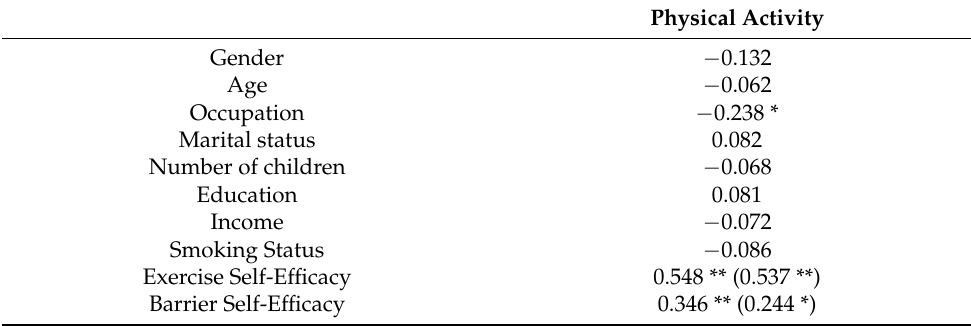
Table 2. Correlations of physical activity, demographic variables, and SCT